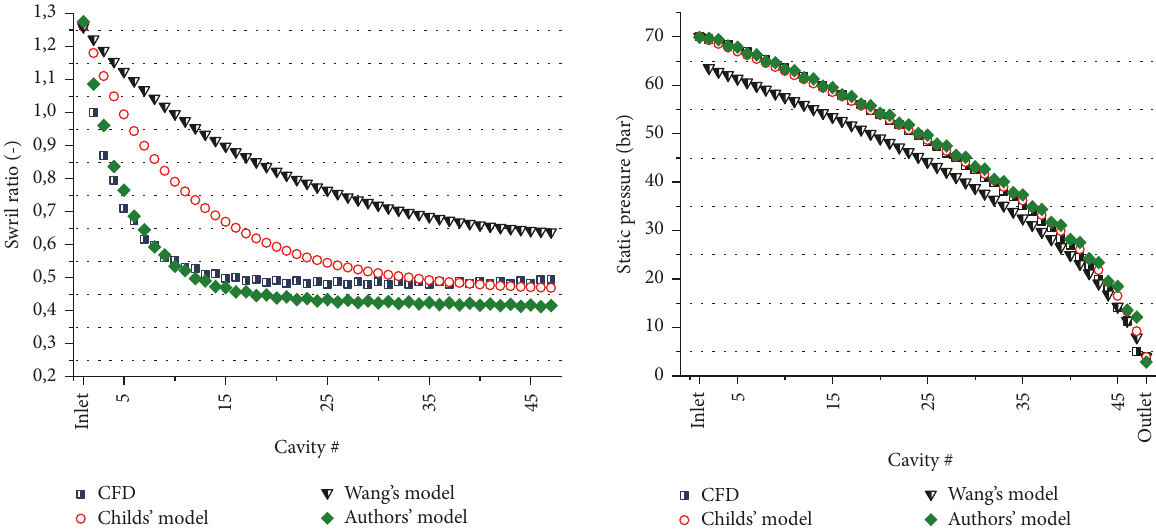
Figure 22: Comparison of the swirl ratio and of the static pressure in the seal cavities evaluated with the CFD, Childs’ model, Wang’s model, and authors’ model.